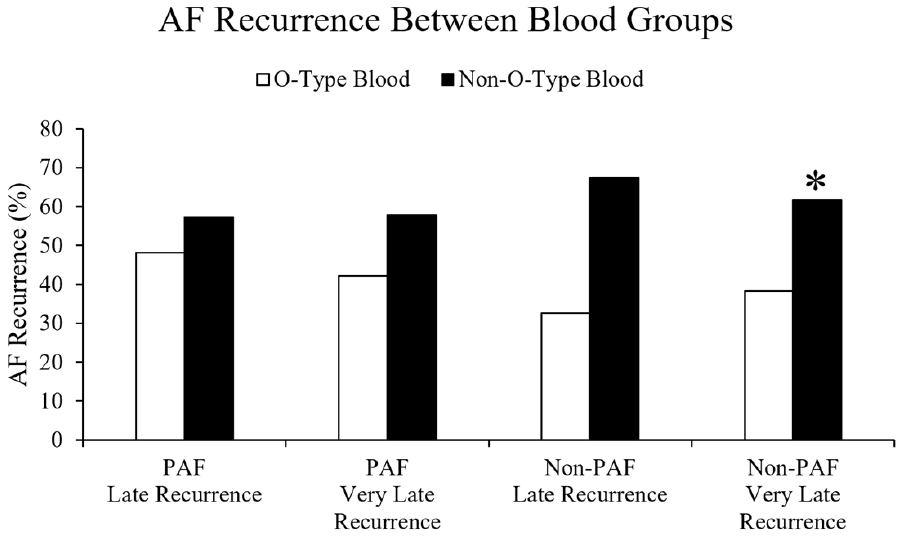
Figure 1. Incidence of AF recurrence between blood groups after catheter ablation. The incidence of late and very late AF recurrence in the PAF patients revealed no difference between the different blood groups. The very late AF recurrence of the non-O-type blood groups (A, B, or AB type) in the non-PAF patients was significantly higher than those in the O-type blood group. * p < 0.05 compared with the O-type blood group within the